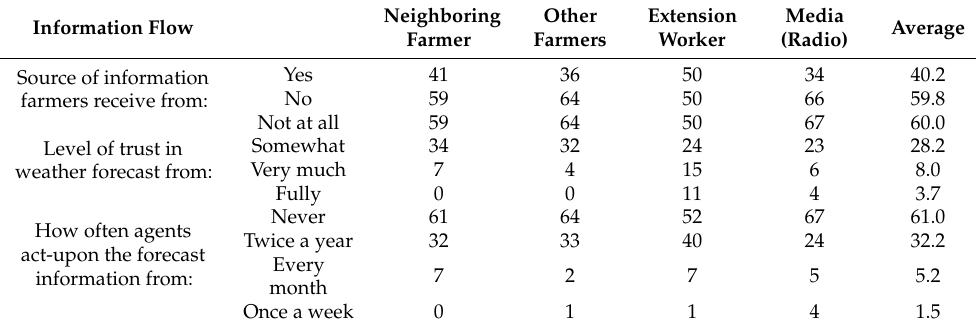
Table 2. Information flow through agent types.